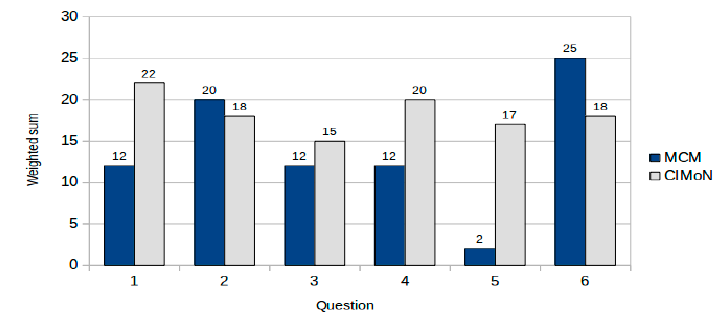
Figure 2. Weighted sums for questions results.